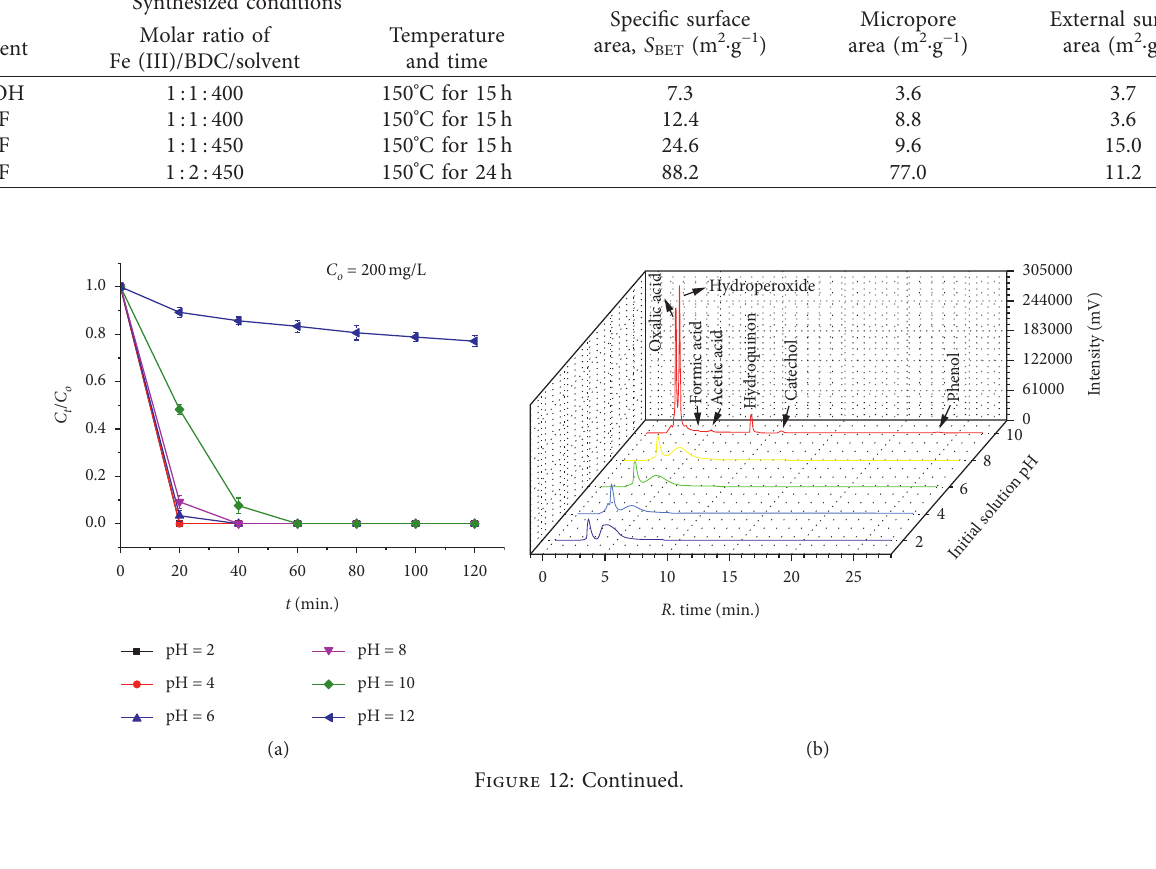
Table 1: Textural properties of iron (III) benzene dicarboxylate samples synthesized under different conditions. Synthesized